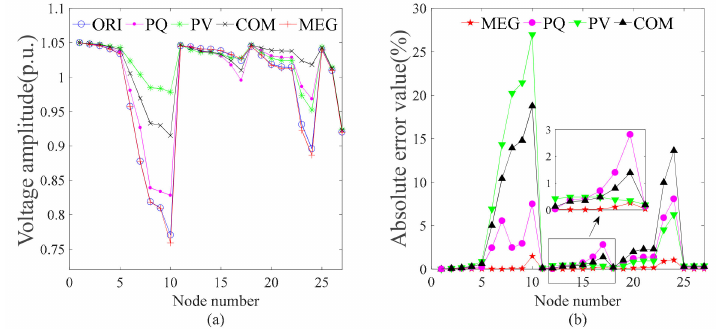
Figure 8. Static simulation result of the internal system in Scenario 2. ( a ) Voltage amplitude. ( b ) Equivalent errors of four models.